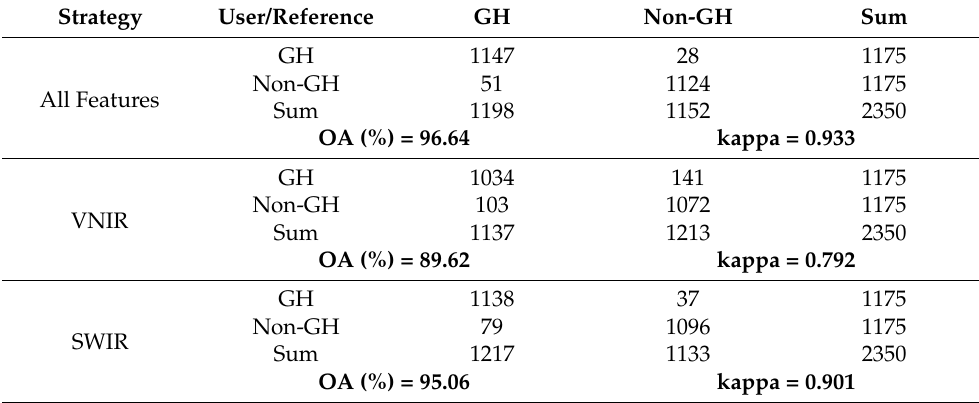
Table 3. Object-based confusion matrices for the three tested